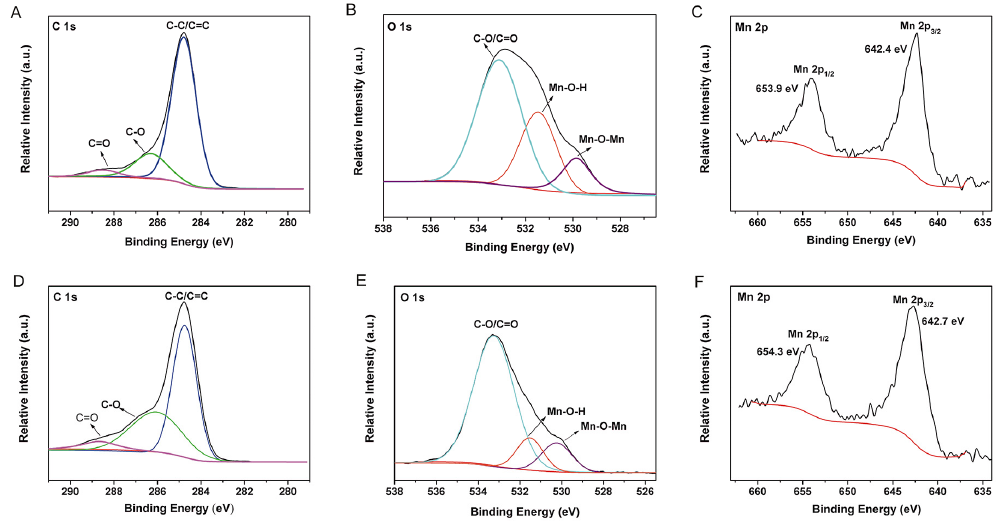
Figure 6. XPS spectra of SSM ( A – C ) before and ( D – F ) after CTC degradation. The UV–Vis diffuse reflectance spectra (DRS) of MnO 2 and SSM were recorded to calculate the bandgap energy of the photocatalyst (Figure S1). The bandgap energy could be estimated by Kubelka–Munk transformation, ahv = A ( hv–Eg ) n / 2 , where a , h , v , Eg repre- sent the absorption coefficient, Plank’s constant, light frequency, and band gap energy, respectively [27]. Based on the above transformation, the Eg value of SSM was calculated as 1.75 eV (Figure S1).